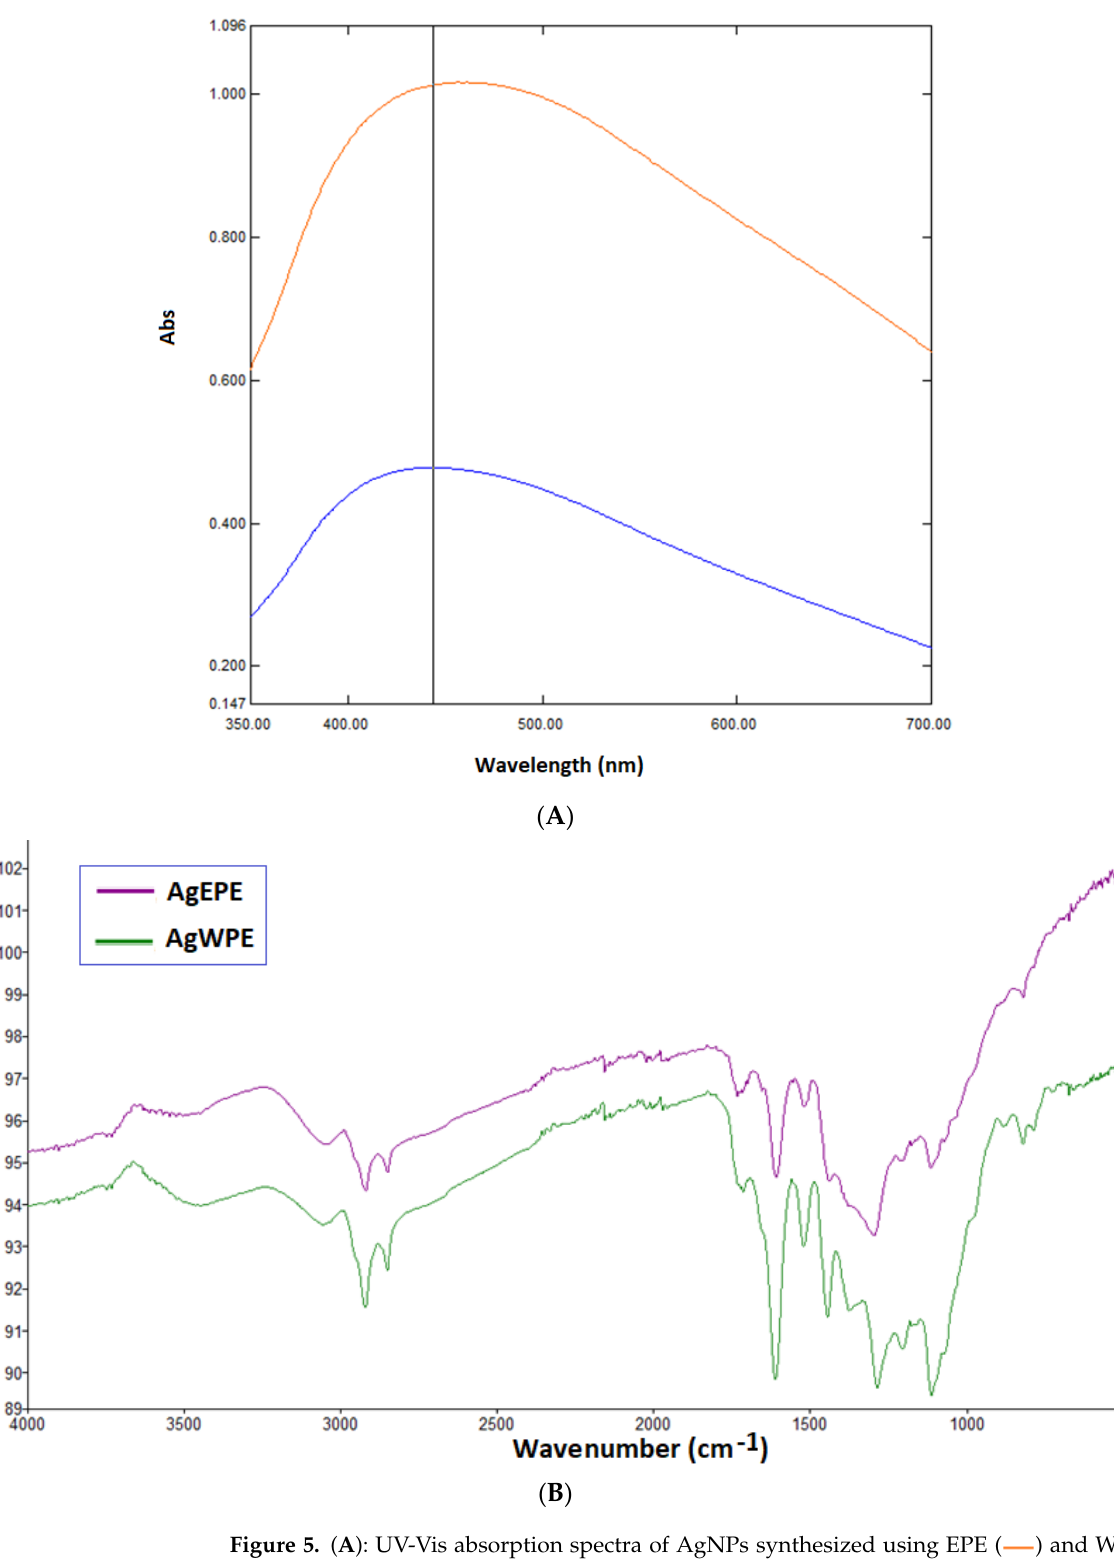
) and WPE ( Figure 5. ( A ): UV ‐ Vis absorption spectra of AgNPs synthesized using EPE ( ) and WPE( );